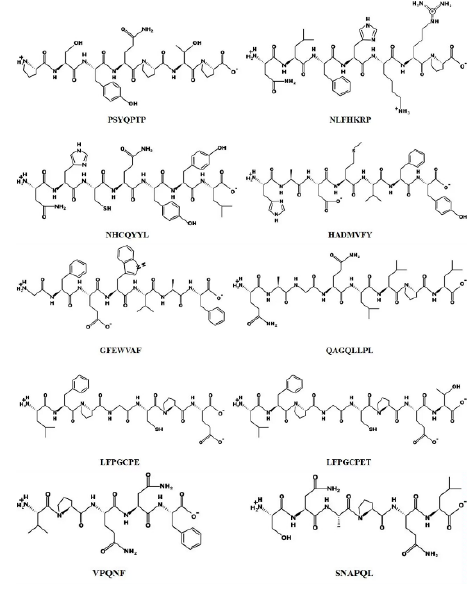
Figure 10. Chemical structures of the ten peptides.